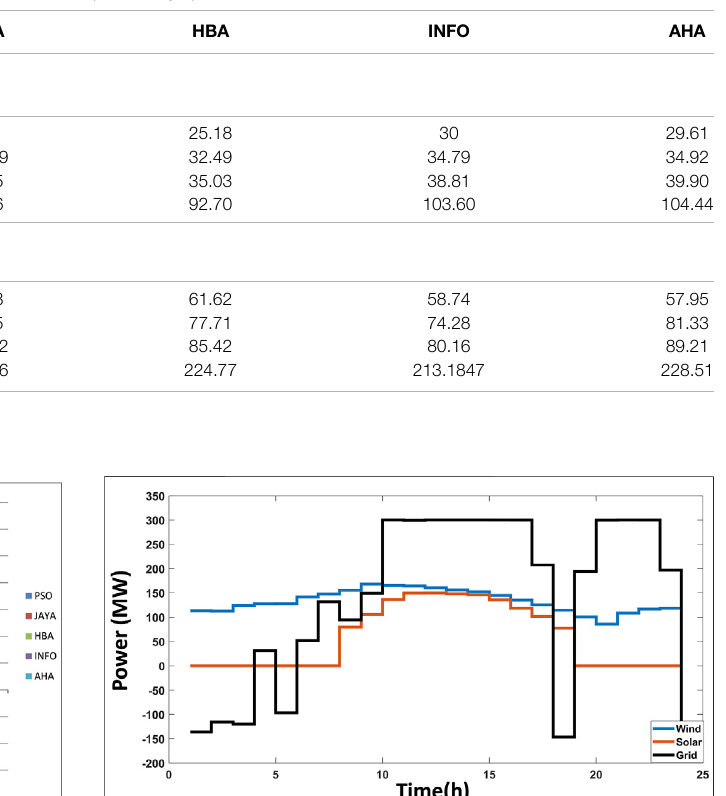
TABLE 9 | Total amount of energy saved and the total amount of incentive received (case study 1).